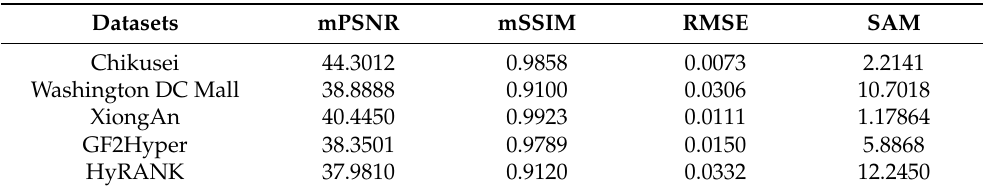
Table 5. Quantitative results of pre-trained model by fixed masking strategy with three channel inputs. The model is trained with a 90% masking